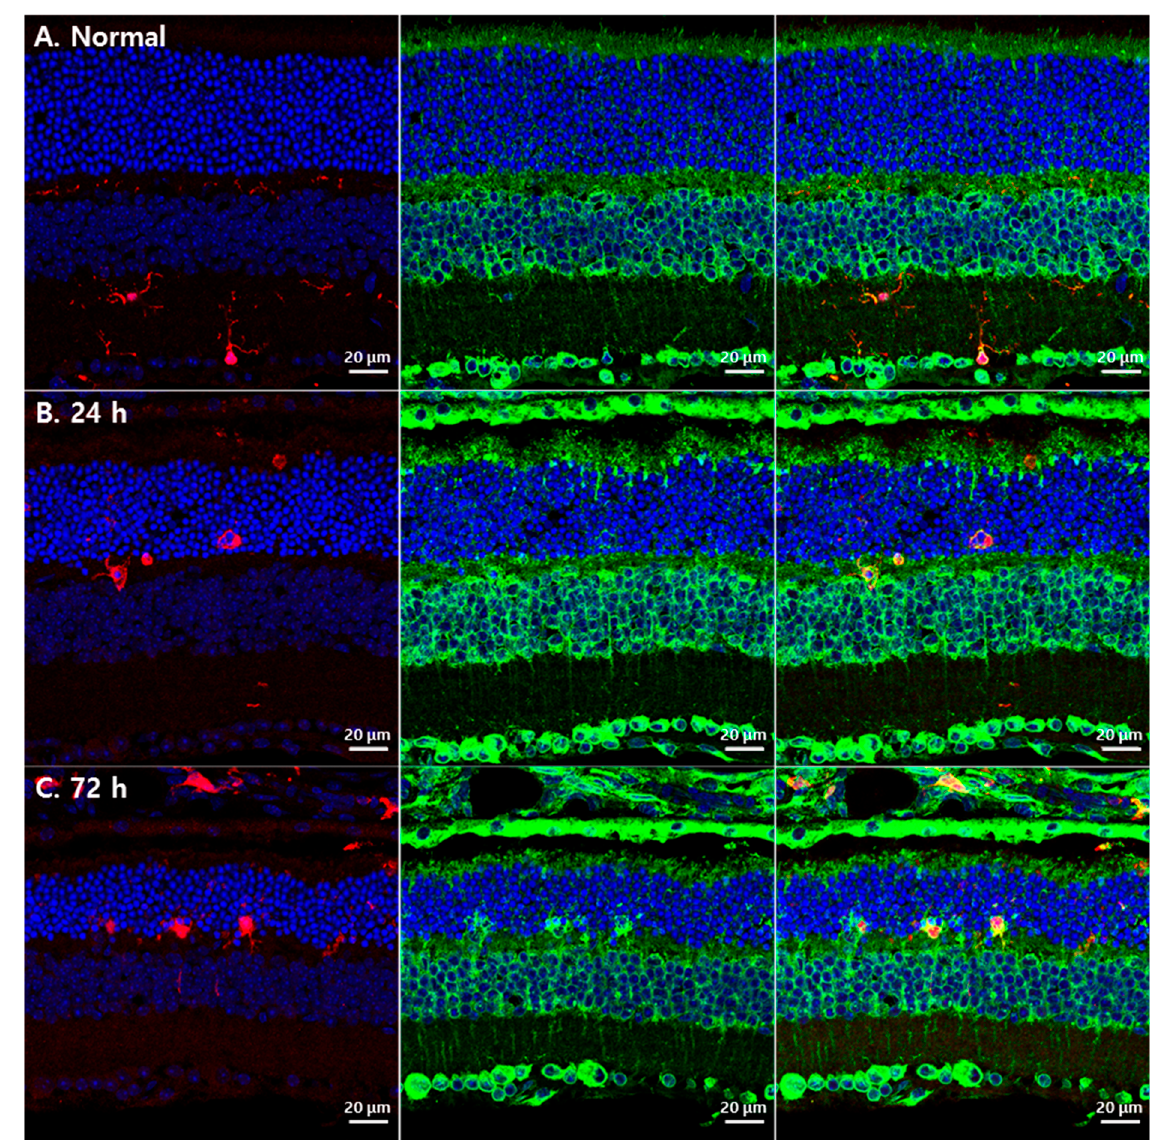
Figure 3. GRP78 expression in microglial cells in blue LED-induced RD retinas. ( A ) A representative confocal image of the normal retina labeled by DAPI (blue), GRP78 (green) and IBA1 (red). IBA1-labeled microglial cells were weakly labeled by GRP78 in the normal retina. ( B ). After 24 h of light exposure, microglial cells were detected in the ONL with an enlarged shape and increased GRP78 compared with the normal retina. ( C ) After 72 h of light exposure, microglial cells were markedly increased in the ONL and GRP78 was prominently increased in microglial cells compared with those after 24 h.